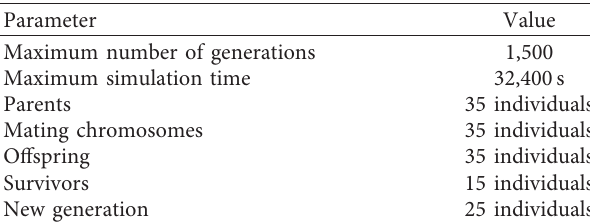
Table 2: Configuration of the genetic